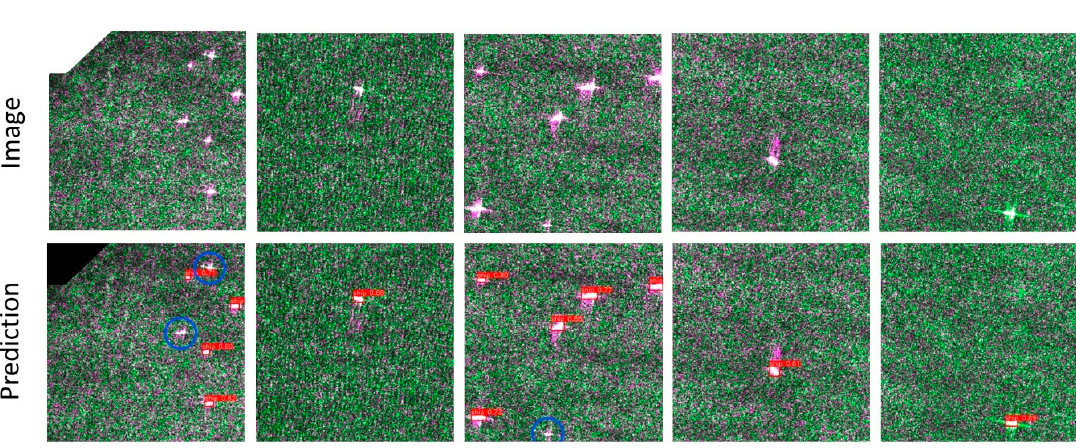
Figure 4. Input Sentinel-1 RGB composite images and output predictions, red labels are predicted ships. Blue circles are false negatives.